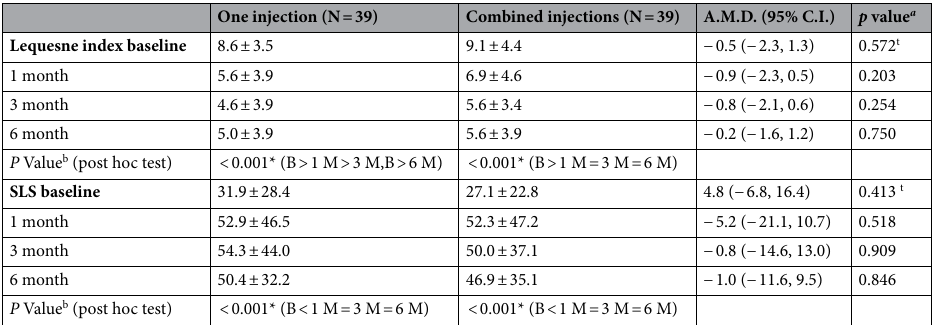
Table 4. The comparison of outcome measures of Lequesne index and SLS. The values are given as mean ± standard deviation SLS Single limb stance, A.M.D. Adjusted mean difference, C.I . confidence interval. a Between-group difference using independent samples one-way ANCOVA (baseline data as covariate). b Within-group difference using repeated measure one-way ANOVA. t Independent t-test. * p value < 0.05.